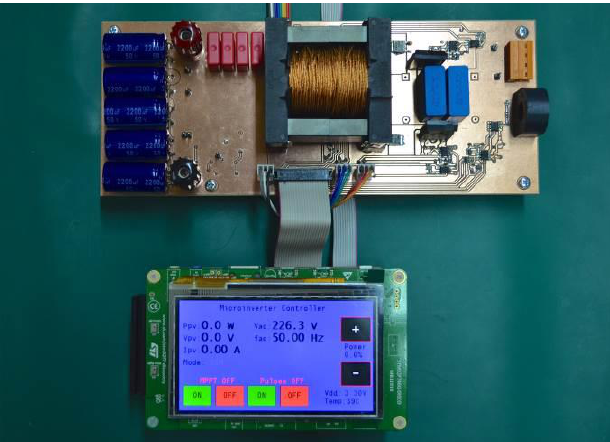
Figure 5. Laboratory experimental prototype. Table 2. Inverter design parameters.